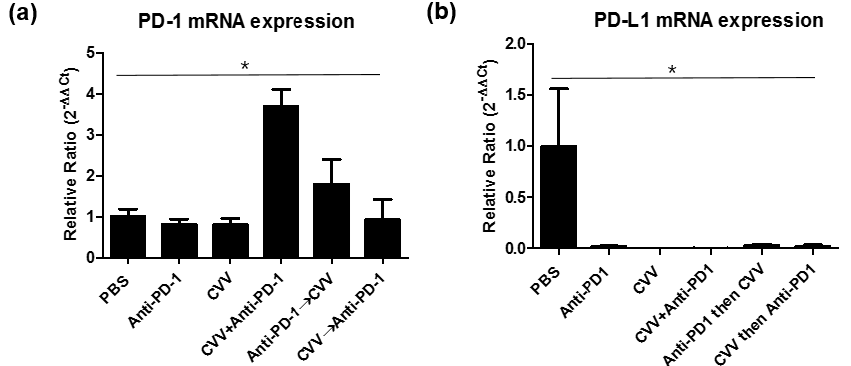
Figure 6. mRNA quantification of PD-1, and PD-L1 from CT26 tumors. After 40 days, tumors derived from responders were harvested, total RNA was extracted, and cDNA was synthesized for mRNA quantification. ( a ) PD-1 expression. ( b ) PD-L1 expression from different groups. The relative ratio (β-actin used for normalization) was used to quantify mRNA expression. mRNA, messenger RNA; PD-1, programmed cell death protein-1. * p < 0.05, one-way ANOVA.